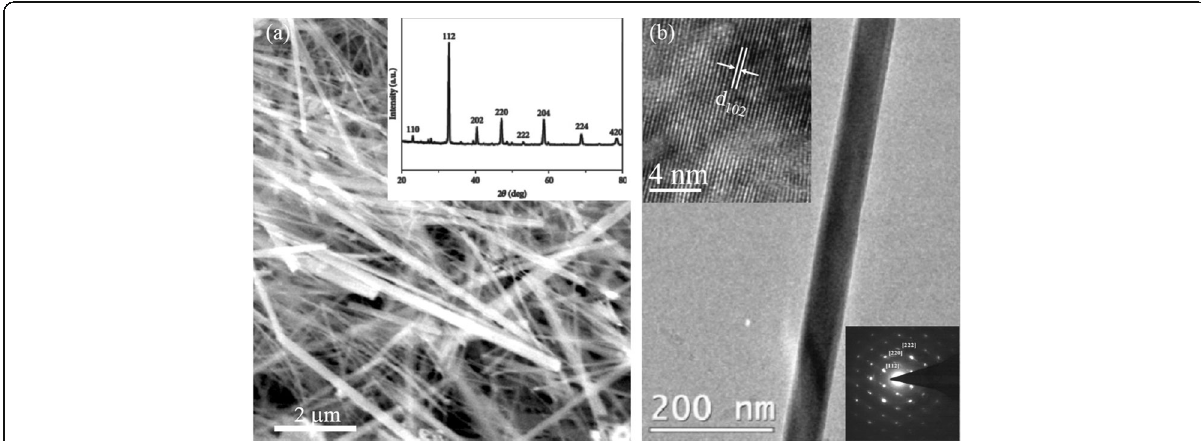
Fig. 9 a SEM and b TEM images of the La 0.5 Sr 0.5 MnO 3 (LSMO) nanowires synthesized by hydrothermal method. Inset in ( a ) is the XRD pattern of the LSMO nanowires, confirming the phase formation and phase purity. Insets in ( b ) are the selected area diffraction pattern and HRTEM image taken from a single LSMO nanowire, revealing the single crystalline nature of the LSMO nanowire. Reproduced with permission of